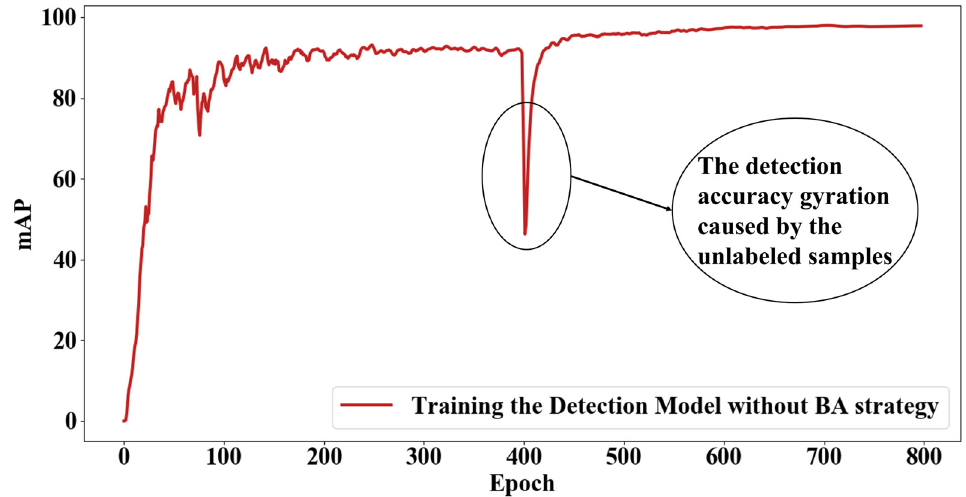
Figure 5. mAPs of each epoch in training process without batch-adding strategy.